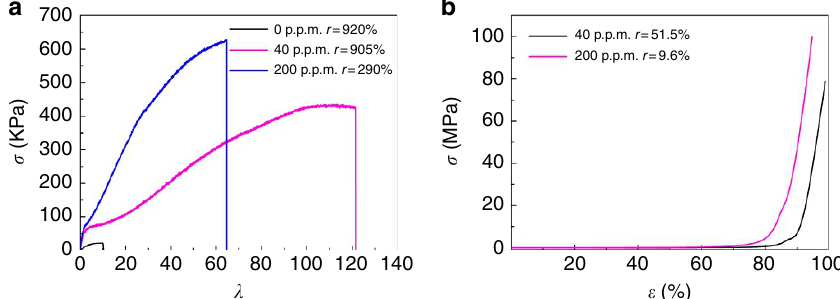
Figure 7 | Elongation and compressive tests of PAM/CNS NC gels at 25 (cid:2) C. ( a ) Representative elongation stress–strain curves of PAM hydrogels containing 0, 40 and 200p.p.m. CNS. s represents the stress. l represents the stretch ratio. r represents the ratio of the length change along the direction of load after the load is released with respect to the original length of the specimen. ( b ) Compression stress–strain curves of C40 (NC gel with 40p.p.m. CNS concentration) and C200 (NC gel with 200p.p.m. CNS concentration). e represents the